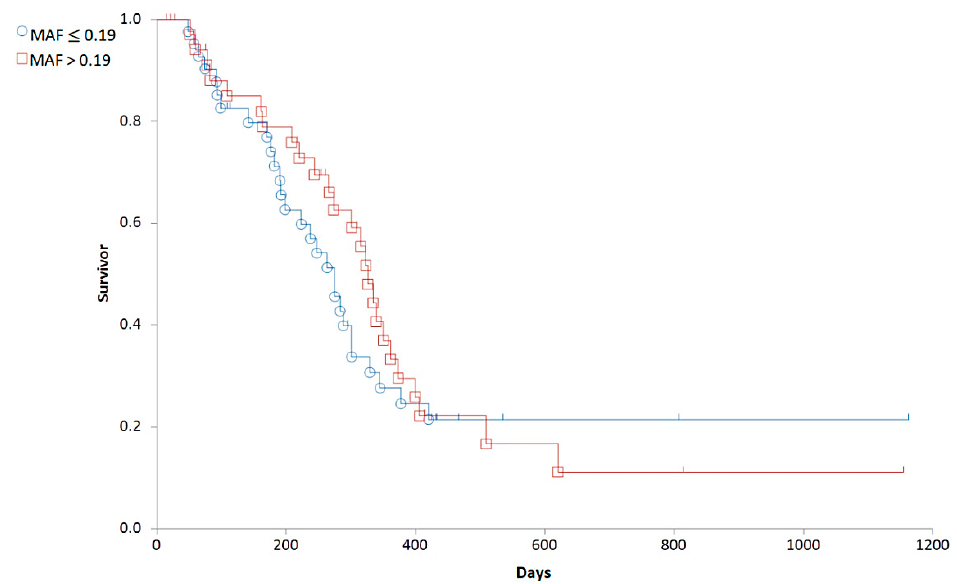
Figure 5. The overall survival of canine lymphoma patients with MAF ≤ 0.19 (blue, circle) and MAF > 0.19 (red, squares).